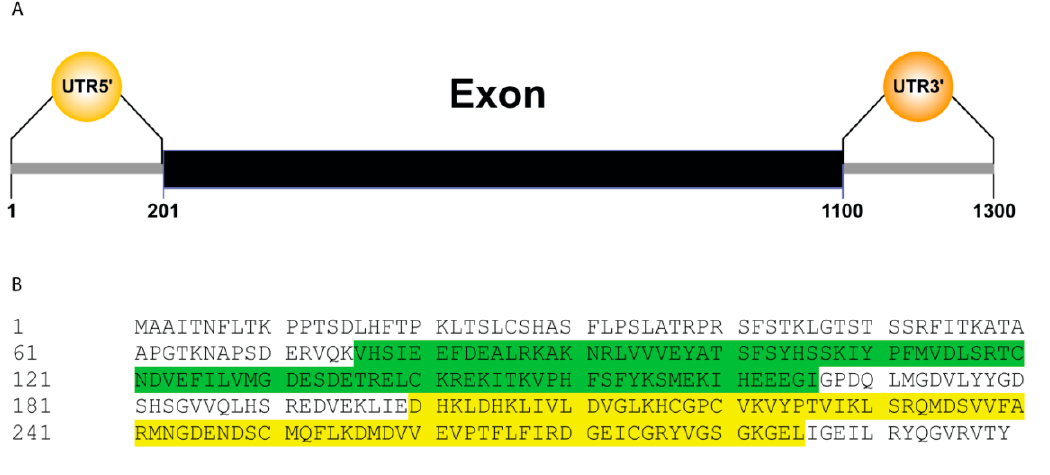
Figure 1. Gene structure was analyzed using expasy ( A ) Schematic structure of the genomic DNA showing exon (black block) and untranslated region (UTR) (grey lines) of GhTRX134 . ( B ) The protein sequence with the two thioredoxins (TRX) domains (PF00085), 76-166 aa and 200-285 aa, are green and yellow highlighted, respectively.